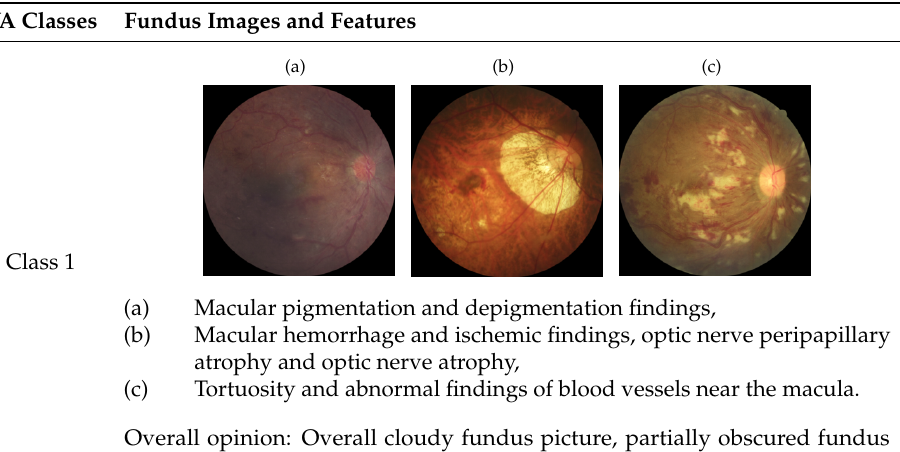
Table 2. Examples of collected fundus images of Classes 1–4 and their